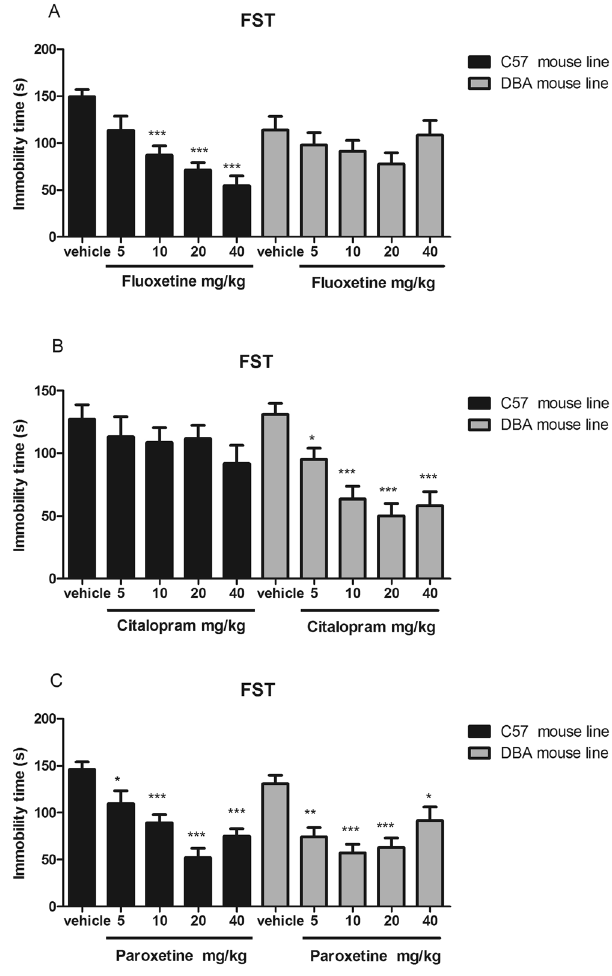
Figure 2. Effects of fluoxetine ( A ), citalopram ( B ) and paroxetine ( C ) on immobility time in the forced swimming test in DBA/2J and C57BL/6J mice. All tests were performed 30 min after i.p. injection of 5, 10, 20, or 40 mg/kg drug. Data are presented as the mean ± S.E.M. (n = 8–10/group). * p < 0.05, ** p < 0.01, *** p < 0.001 versus